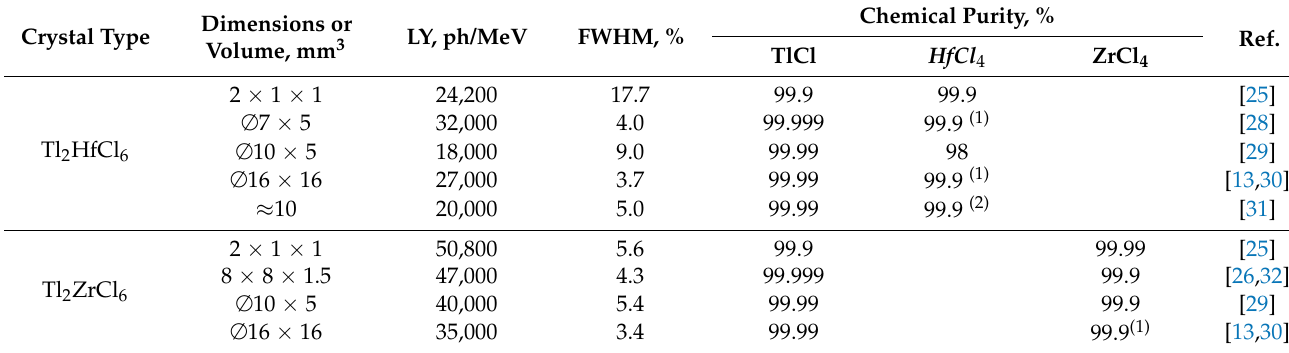
Table 5. List of recently produced Tl 2 HfCl 6 and Tl 2 ZrCl 6 crystals by different groups, crystal dimensions (or volume) used for their characterization, the relative light yield (LY) and energy resolution (FWHM) measured under irradiation by 662 keV gamma line of 137 Cs source, and chemical purity of corresponding raw materials used for crystal